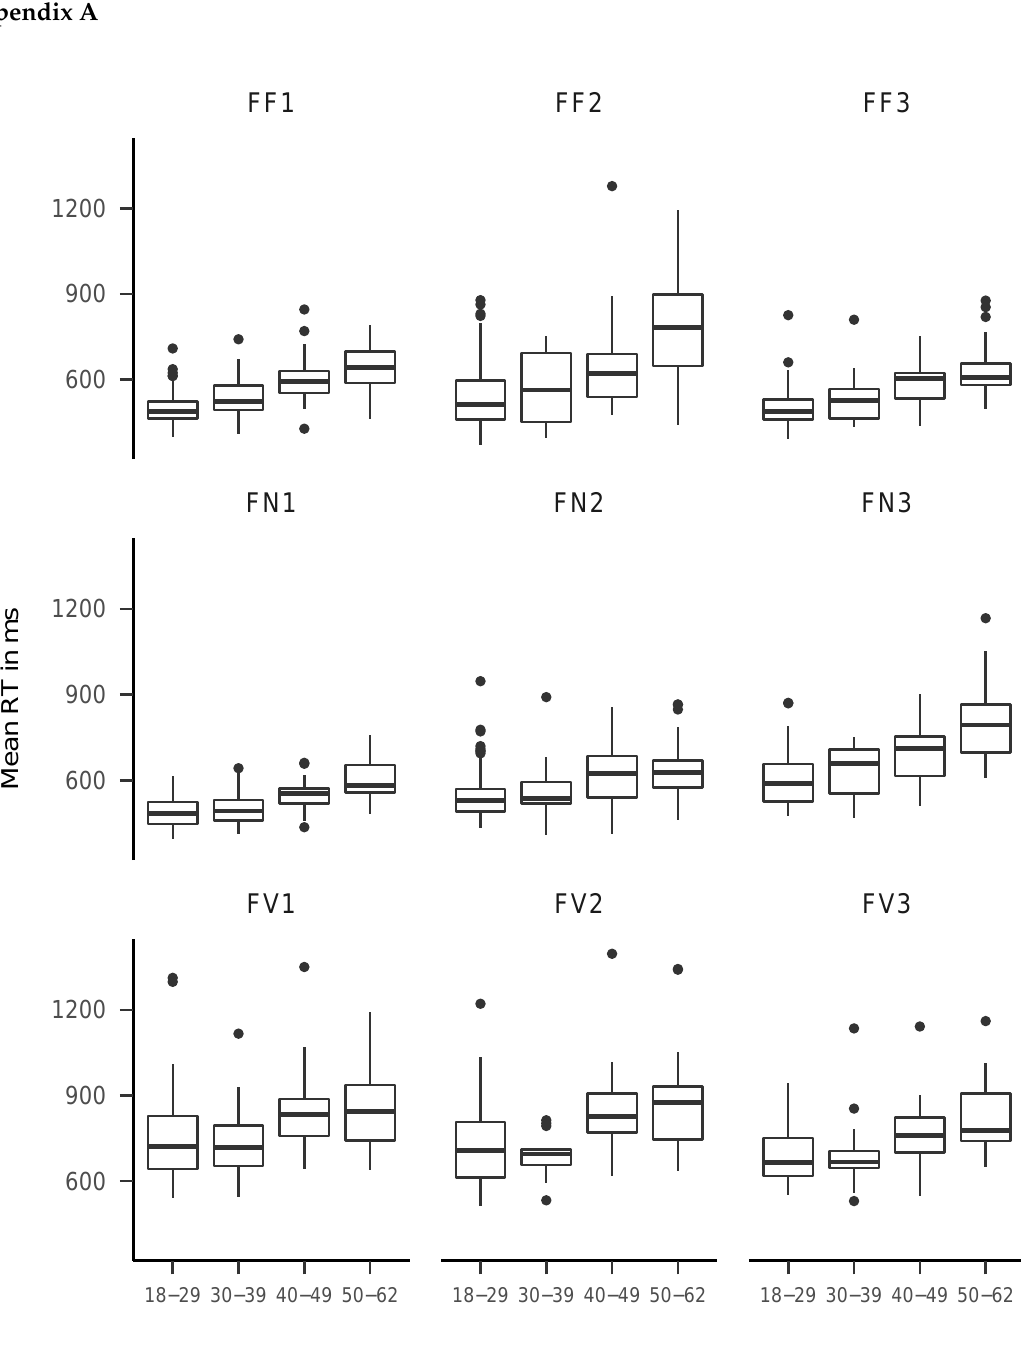
Figure A1. Boxplots of mean response times for all fast tasks, split by age groups. See Table 1 for an explanation of the task